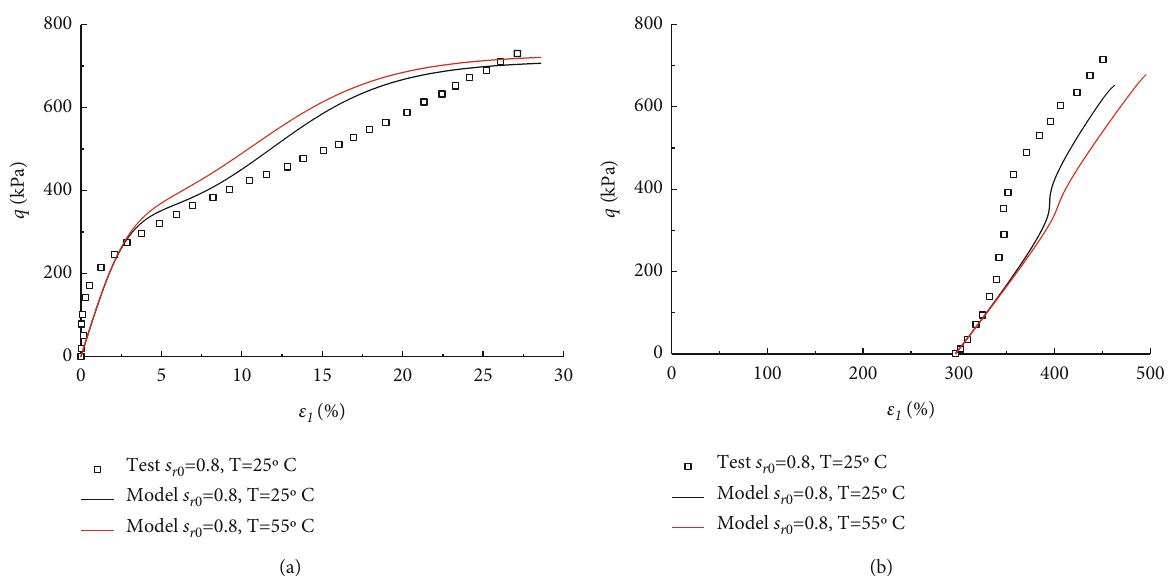
= 0 : 81 ): (a) stress-strain relationship; r 0